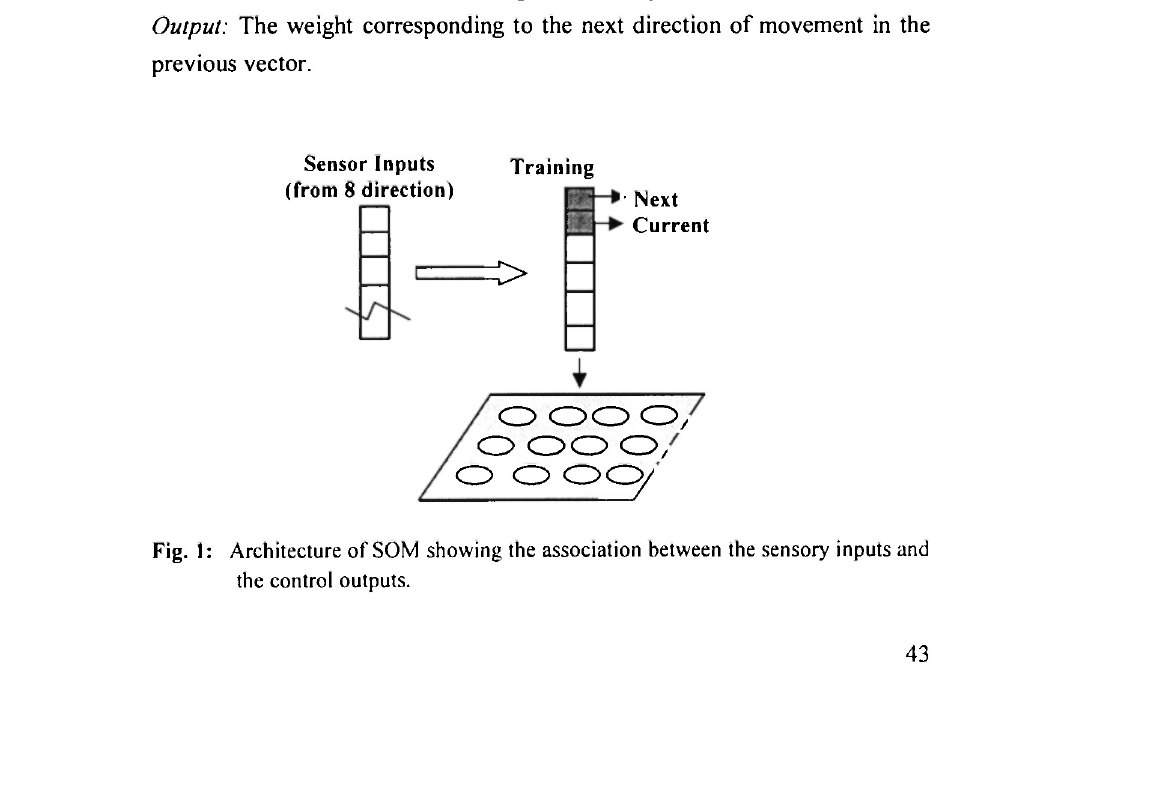
Fig. 1: Architecture of SOM showing the association between the sensory inputs and the control